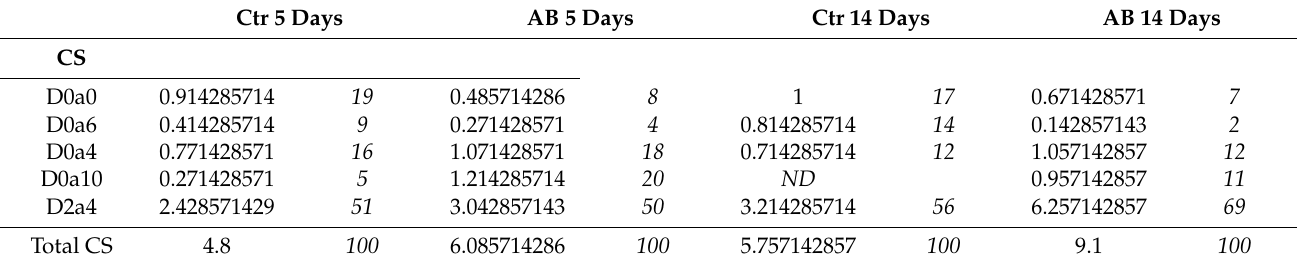
Table 2. Chondroitin/dermatan sulfate content in corneas of wild-type mice 5 and 14 days after